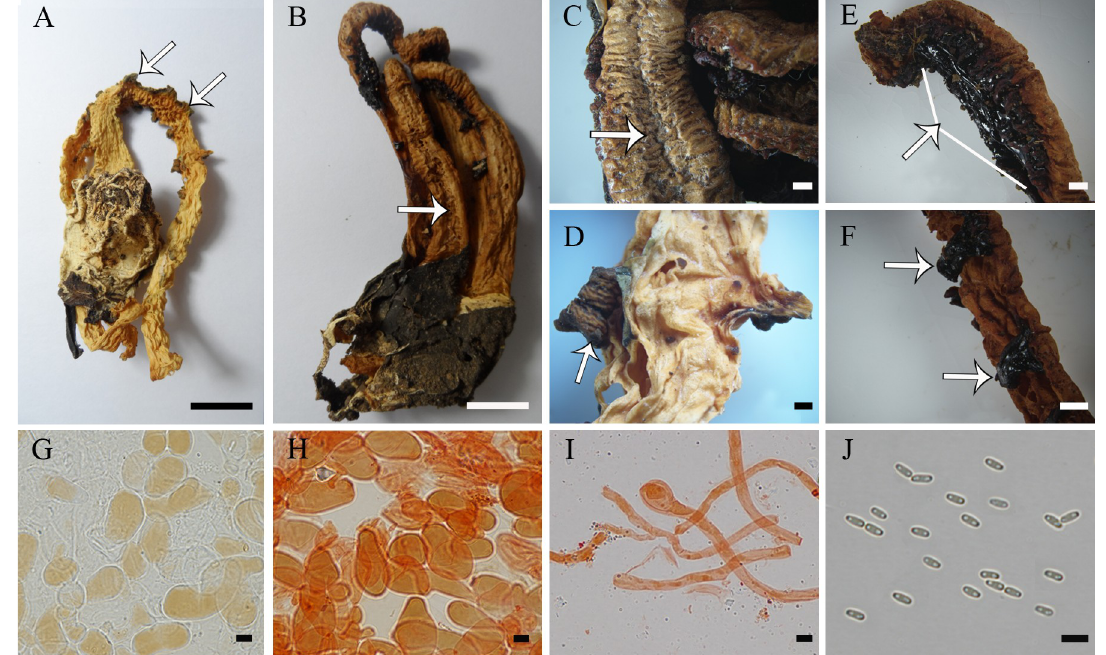
Fig 7. Blumenavia heroica sp. nov. (A–B) Dry basidiomata: (A) S. Chaco´n 5257-A, paratype; (B) XAL R. Medel 672, paratype. (C) Groove in the outer face of the arm, XAL D. Jarvio 370, paratype. (D) Glebifers forming by parallel lines curving inward, S. Chaco´n 5257-A, paratype. (E, F) XAL R. Medel 672, paratype: (E) Glebifers forming by parallel lines curving inward not sparse in the upper half of the basidiomata; (F) Spaced glebifers. (G, H) XAL E. Ga´ndara 1455, holotype: (G) Apical exoperidium hyphae in 5% KOH; (H) Apical exoperidium hyphae in 1% Congo red. (I) Rhizomorph hyphae in 1% Congo red, XAL S. Chaco´n 4475, paratype. (J) Basidiospores in 5% KOH, XAL E. Ga´ndara 1455, holotype. (A, D, E, F) Arrows indicating glebifers. (B, C) Arrows indicating longitudinal outer groove. (A, B) bar = 10 mm; (C, E, F) bar = 1 mm; (D) bar = 5 mm; (G–J) bar = 5 μ